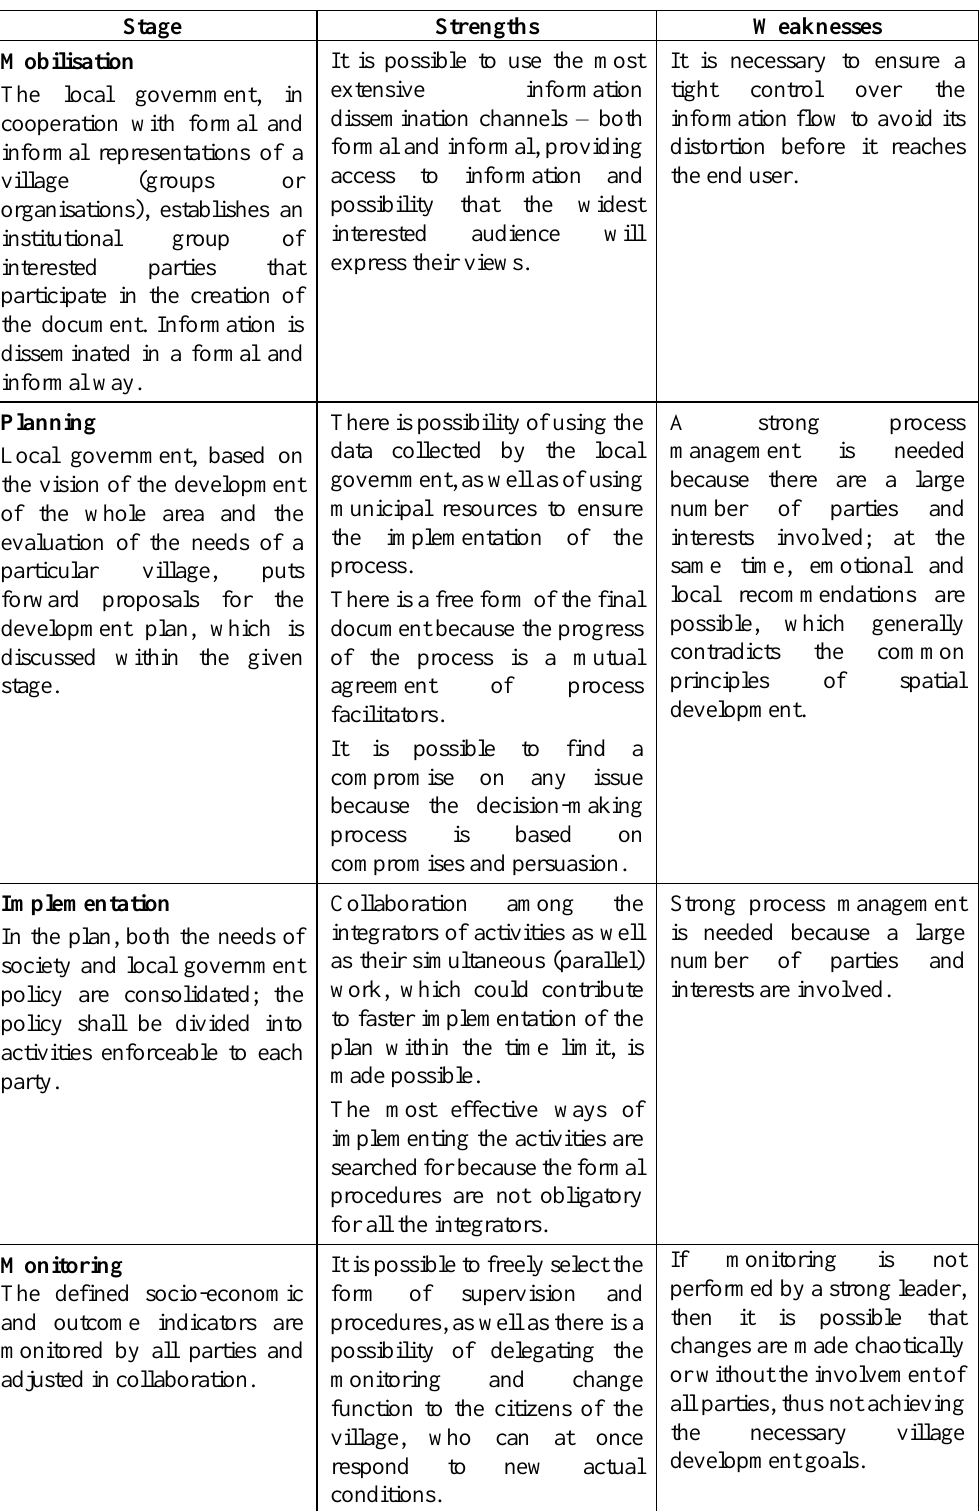
Table 3. Composite Planning Model (developed by the